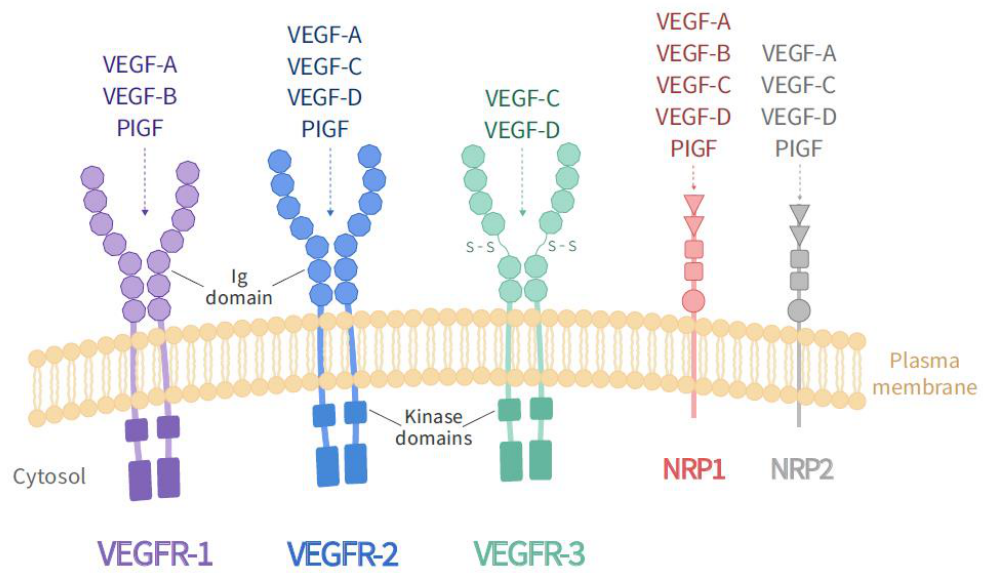
Figure 1. VEGF receptors. The family of VEGF receptors includes three tyrosine kinase receptors (VEGFR-1, VEGFR-2, VEGFR-3) and two non-tyrosine kinase neuropilin receptors (NP-1, NP-2). The different members of the VEGF family bind to the different types of VEGF receptors, as illustrated. The main effect of VEGF-A as a neurotrophic factor is mediated by its binding to VEGFR-2 (Flk-1).